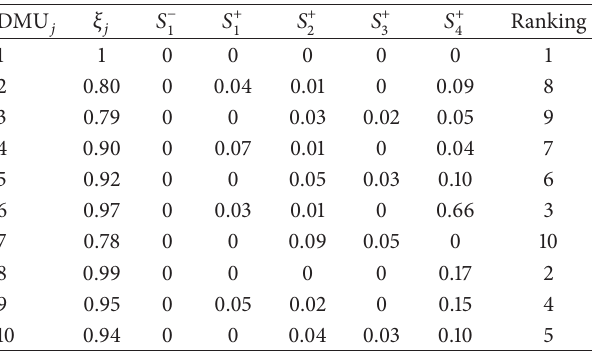
Table 5: Evaluation results of